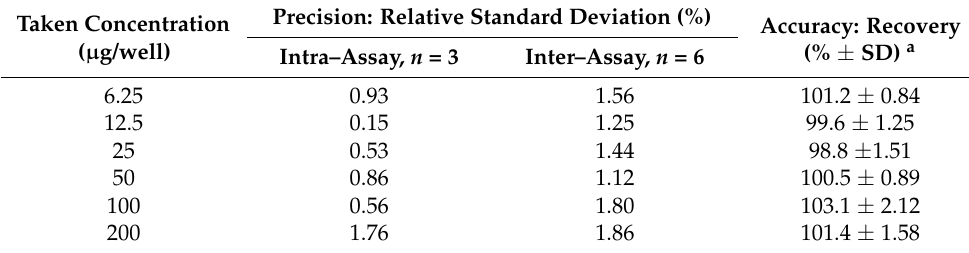
Table 5. MW-SPA precision at various LOR concentration